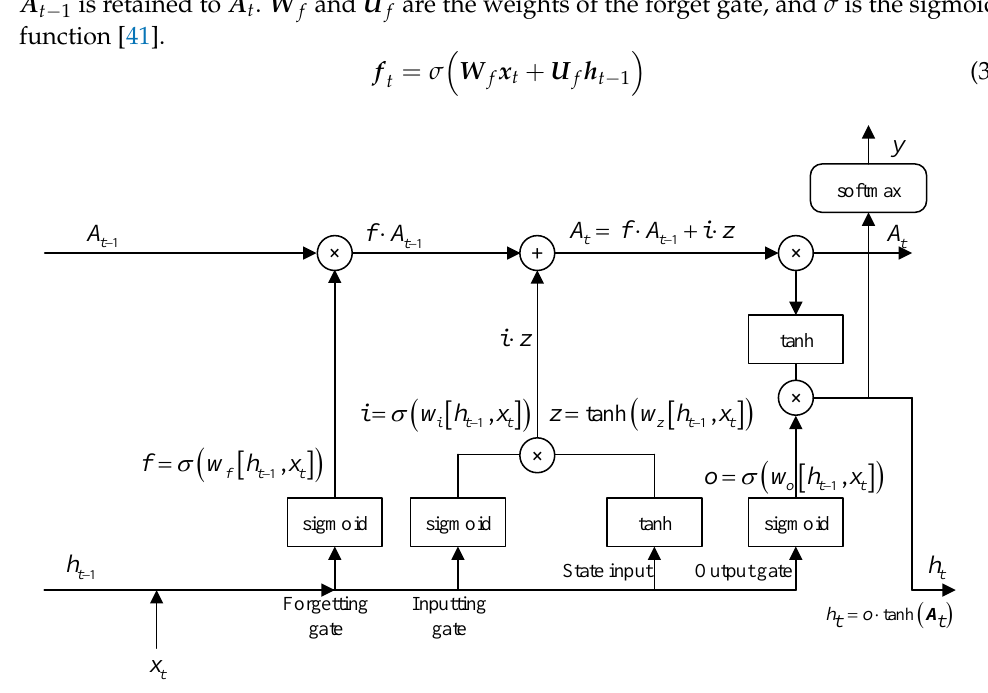
Figure 1. Structure of